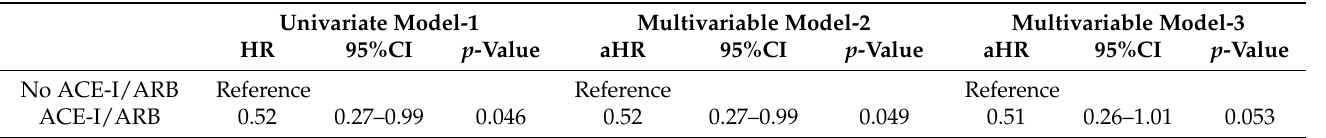
Table 3. Univariate and multivariable Cox regression proportion hazard